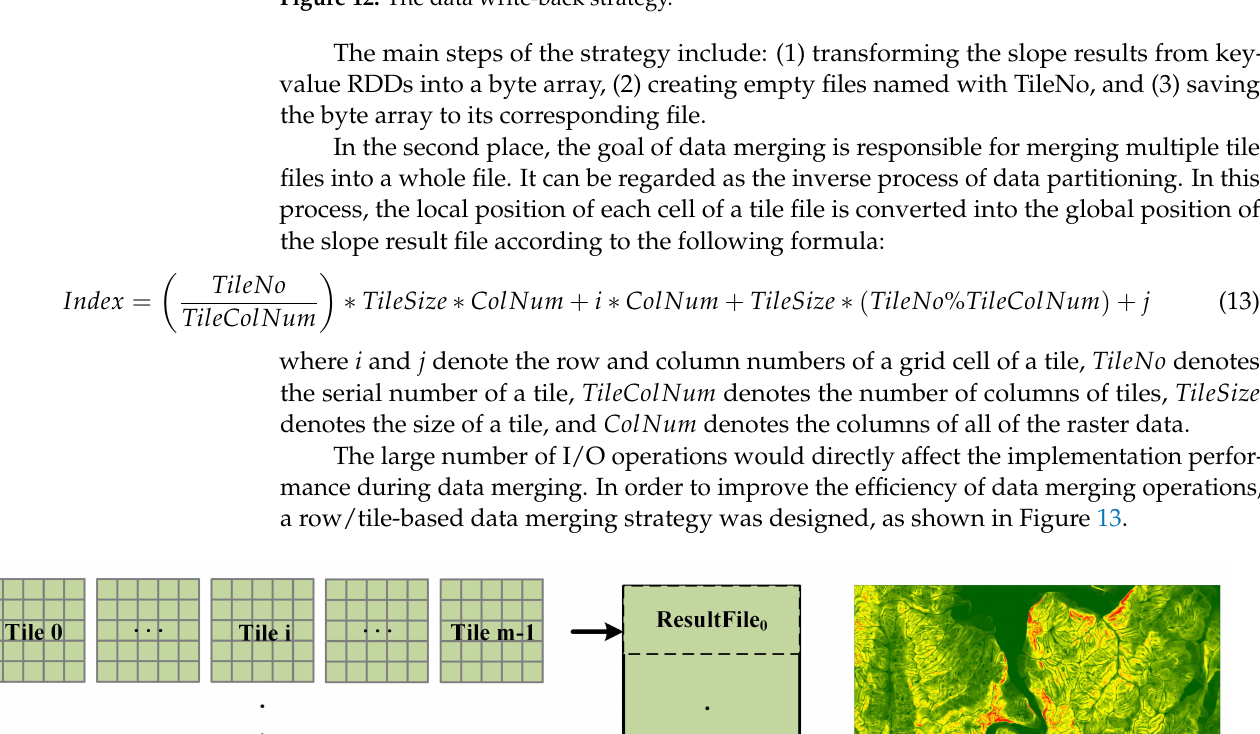
Figure 12. The data write-back strategy.